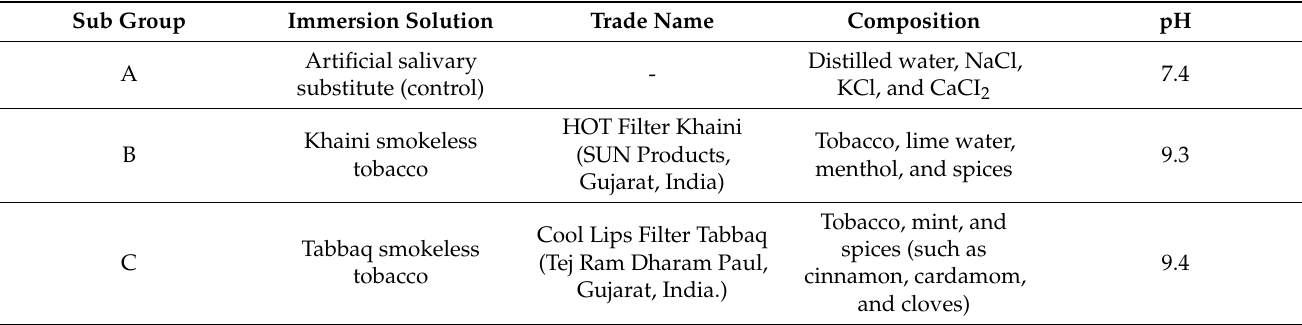
Table 2. Details of the immersion solutions utilized in this